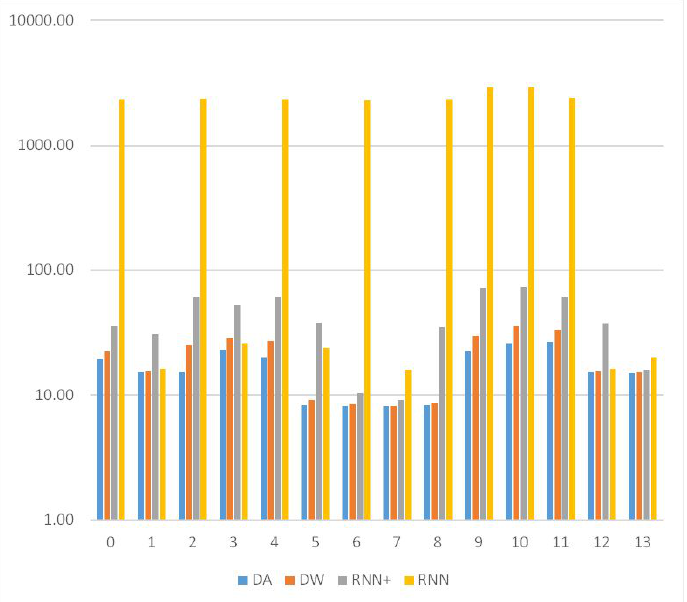
Figure 15. Delays on particular paths (ending node shown on the X